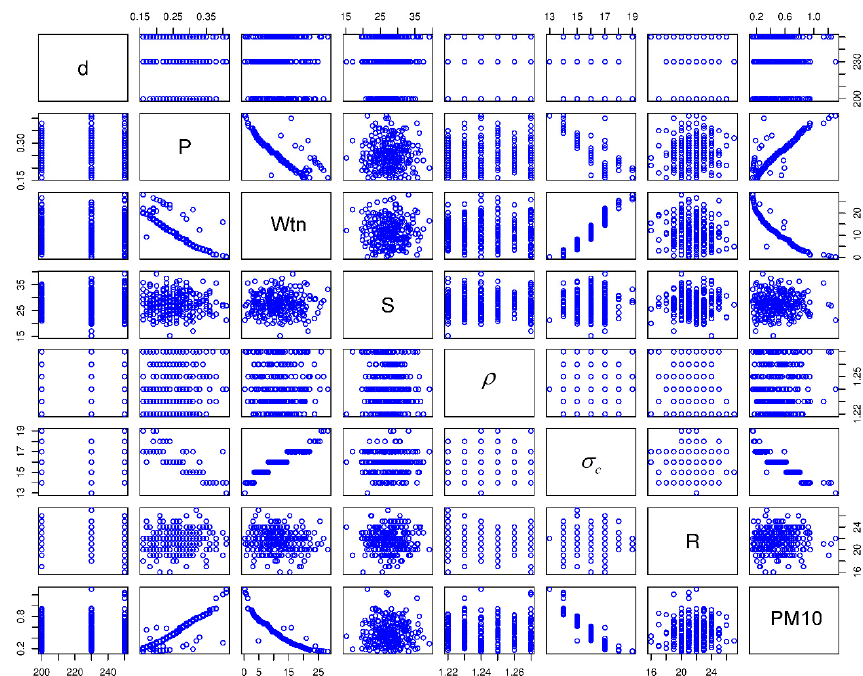
Figure 5. Relationship between input and output variables used in this study.